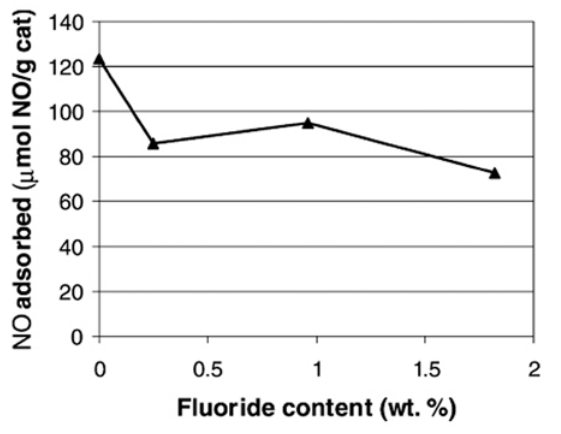
Figure 9. NO adsorbed as a function of fluoride content for sulfided Mo/Al catalysts. Reproduced from reference [114] with permission from